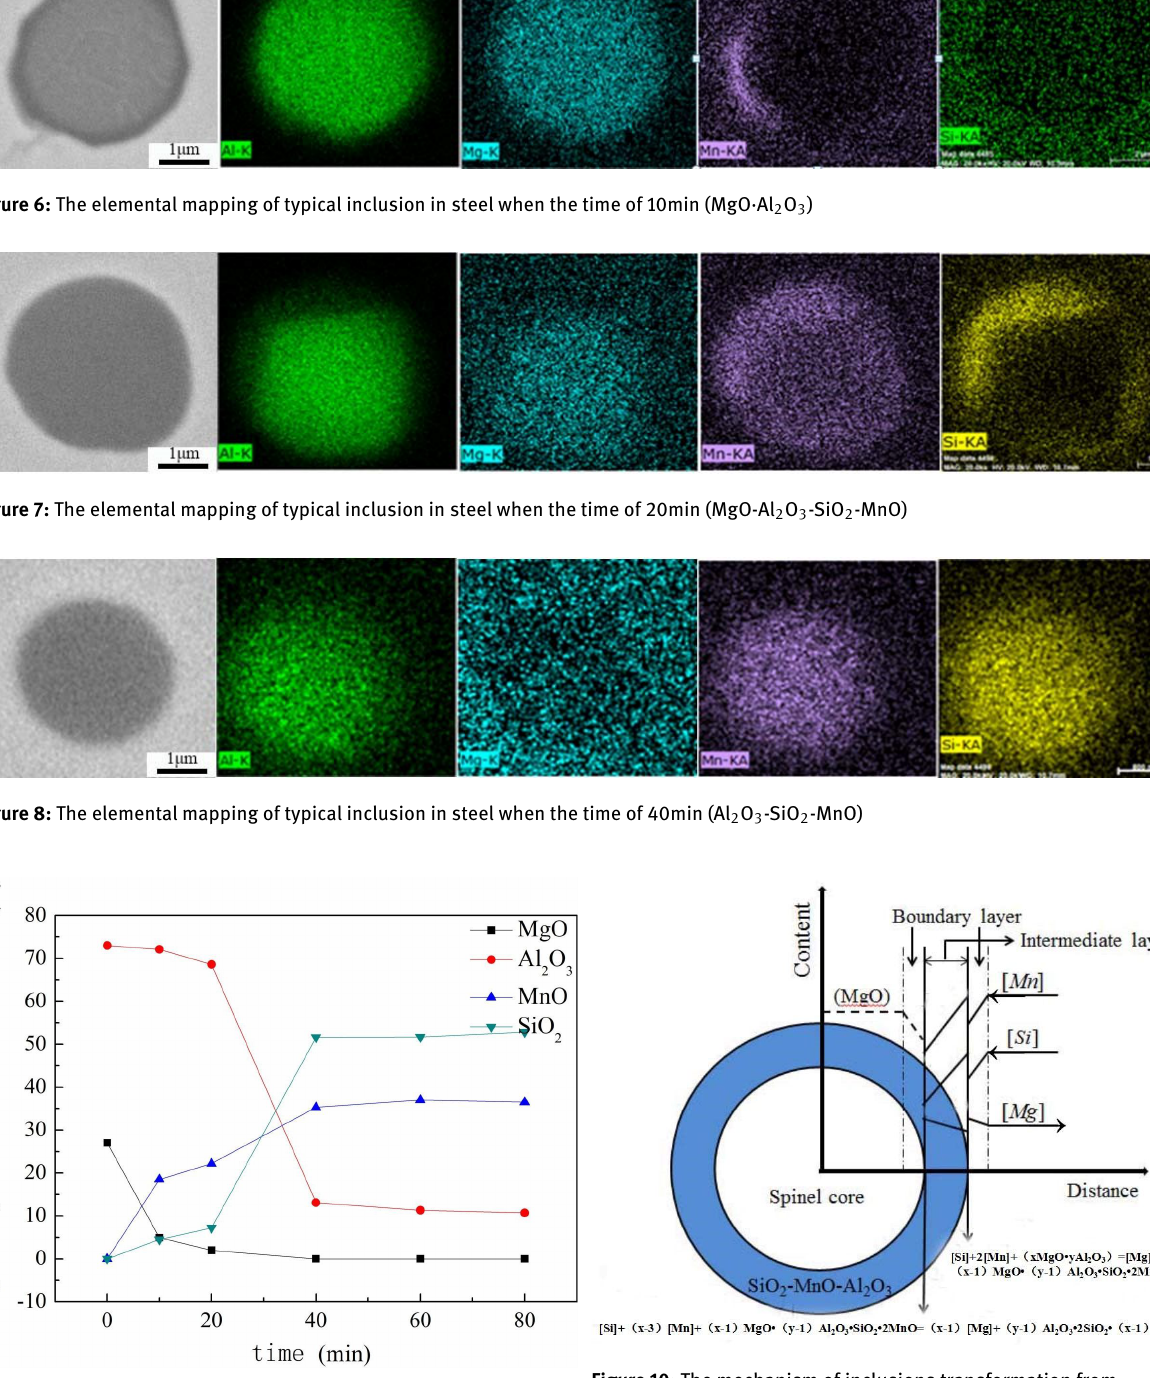
Figure 9: Variation of average composition of inclusions with time